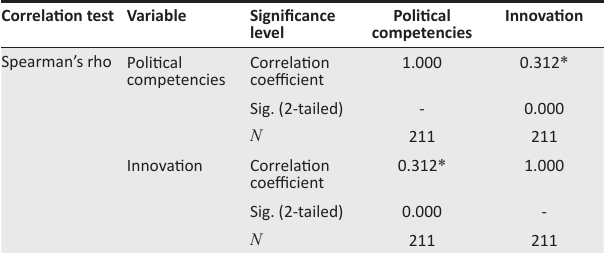
TABLE 4 : Spearman’s correlation on managerial political competencies versus return on investment.